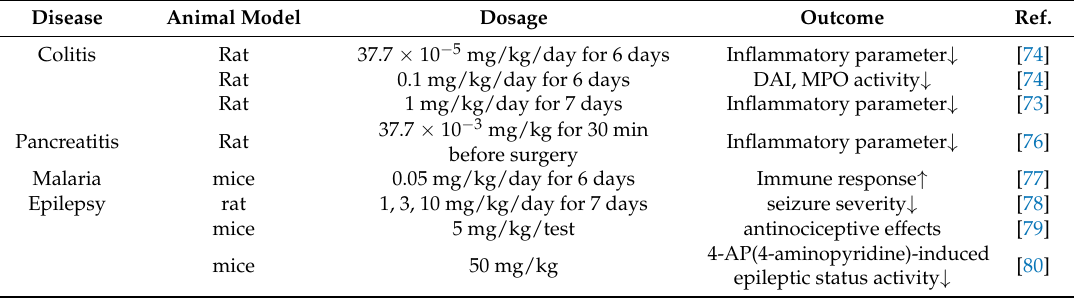
Table 4. Anti-inflammatory effects of capsazepine in preclinical disease